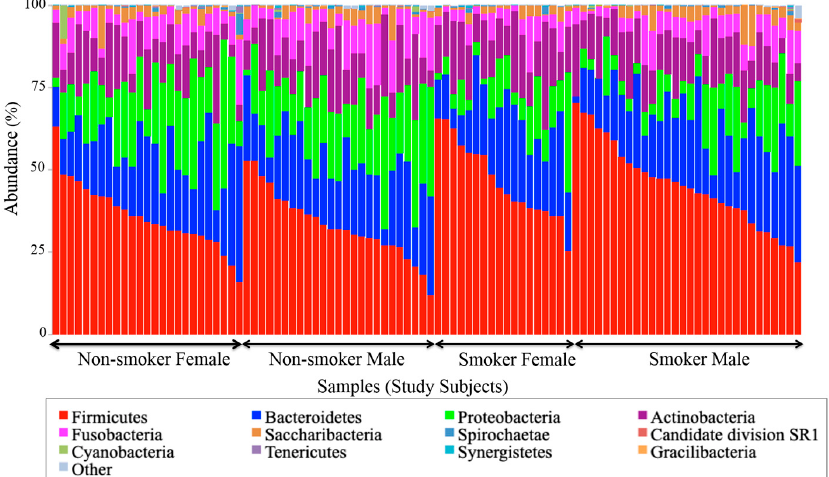
Figure 4. Taxonomic composition represented by the abundance (percentage) of phyla per smoking status per gender for each sample in each comparison group.